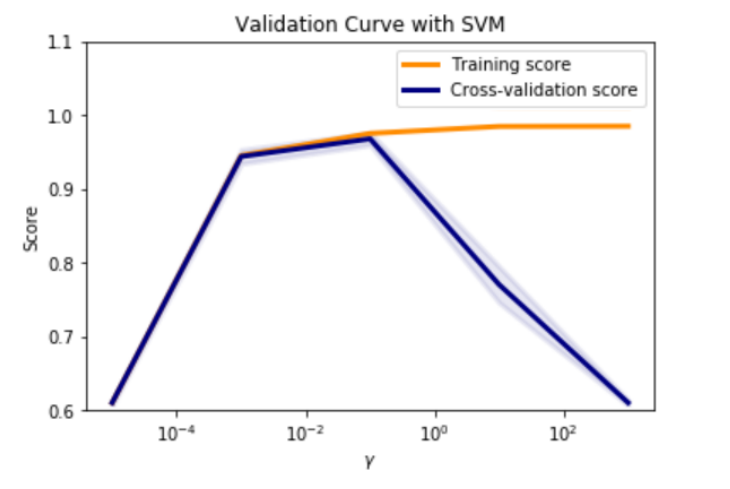
Figure 5. Support Vector Machine scores for electrofacies